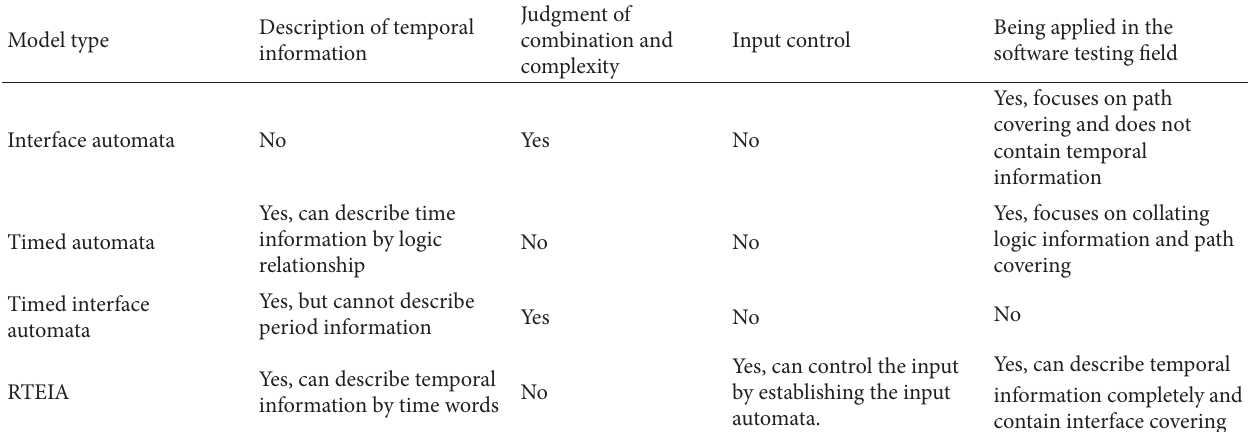
Table 2: Comparing RTEIA with other automata